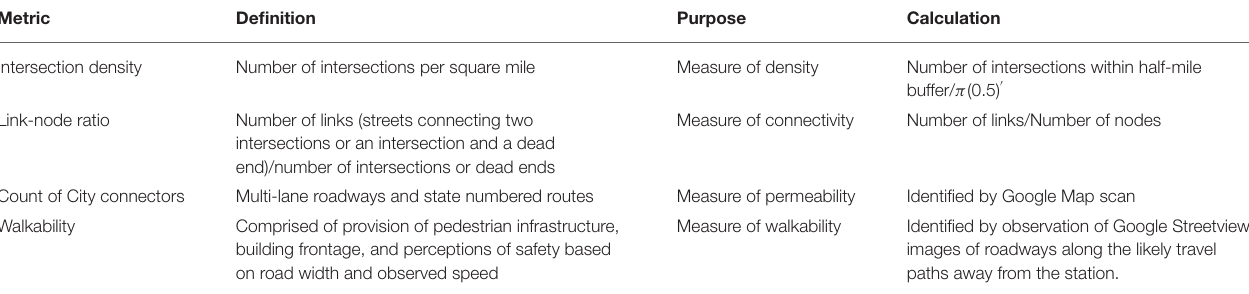
TABLE 1 | Street level analysis metrics.